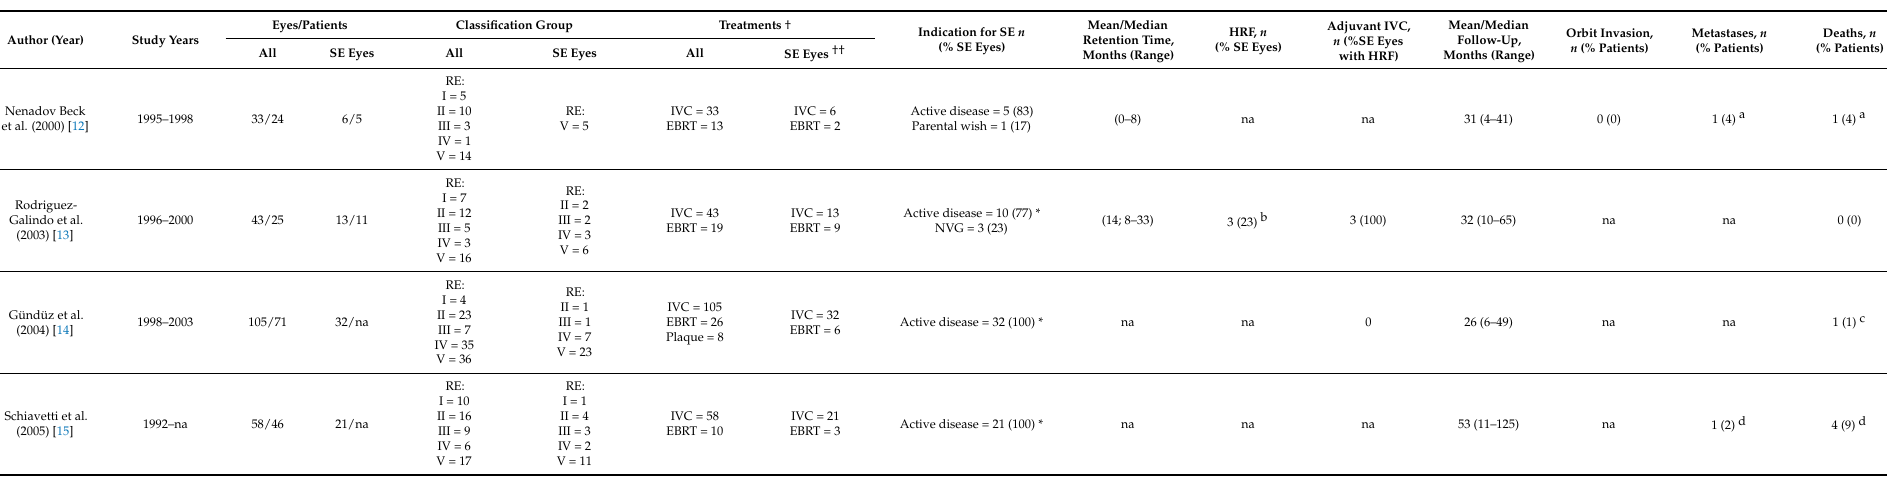
Table 2. Secondary enucleations (SE), orbital invasion, metastases and mortality rates after first-line intravenous chemotherapy (IVC): literature